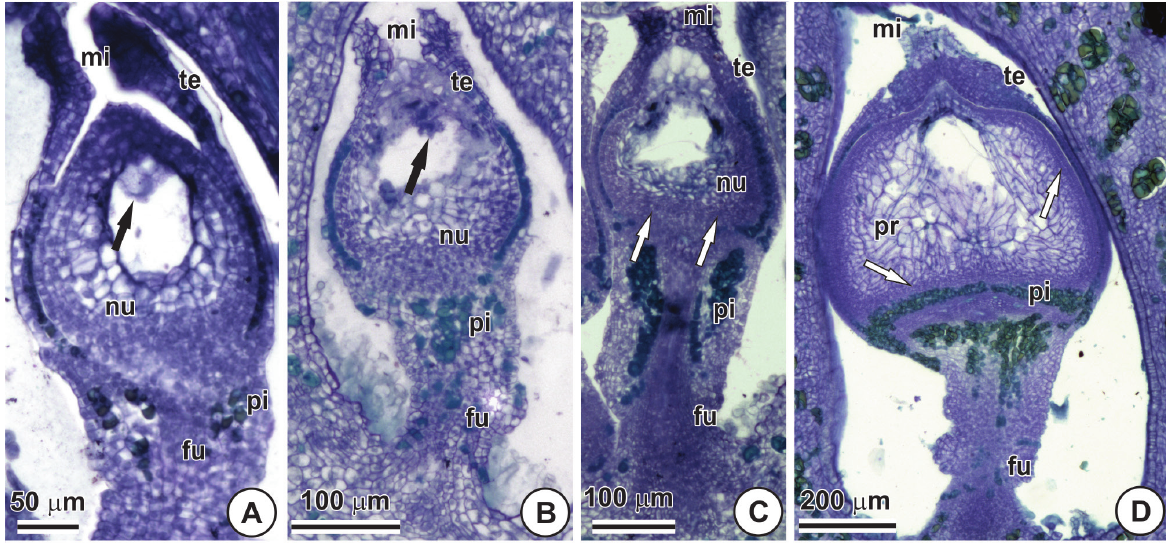
Figure 3 - Longitudinal sections of a seed from an aspermic mutant of Annona squamosa at different stages. Seventy-two hours after pollination, showing an embryo in early development (arrow) (A) . Seven days after pollination, showing a degenerating embryo (arrows) (B) . Ten days after pollination, showing meristematic activity in the nucellus (arrow) (C) . Fifteen days after pollination, showing meristematic activity in the peripheral region of the nucellus (arrows) (D) . fu, funiculus; mi , micropyle; nu , nucellus; pi , idioblasts with phenolic content; pr , perisperm; te ,